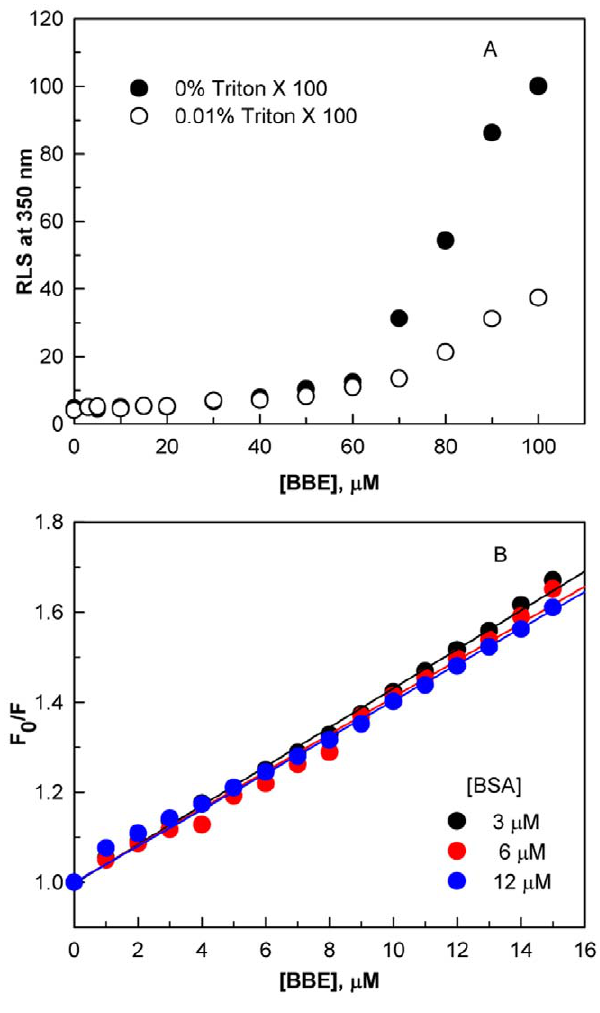
Figure 3. The BBE binding to BSA is specific. Particle formation by BBE in the absence and presence of 0.01% Triton X-100 as monitored by Rayleigh light scattering at 350 nm (A). Stern-Volmer plots of BBE- induced fluorescence quenching of BSA with increasing concentrations of the protein (B).